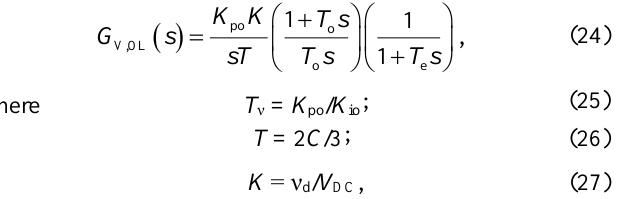
Fig. 10. Step responses of the DC voltage control loop.